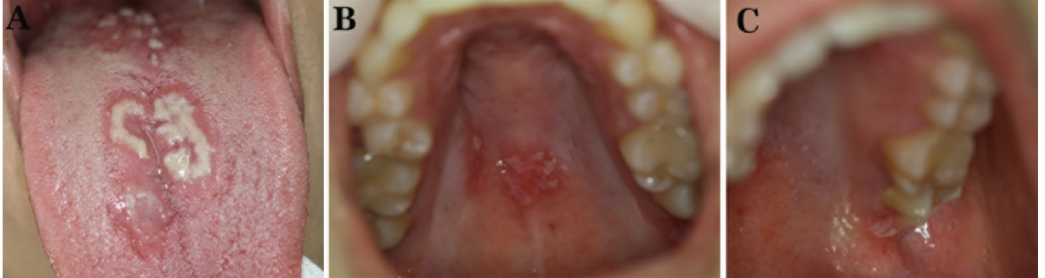
Figure 1. Patient 1. Clinical examination: Partially removable white plaques on erythematous base involving the dorsal tongue ( A ), hard palate ( B ), and left tuberosity ( C ).